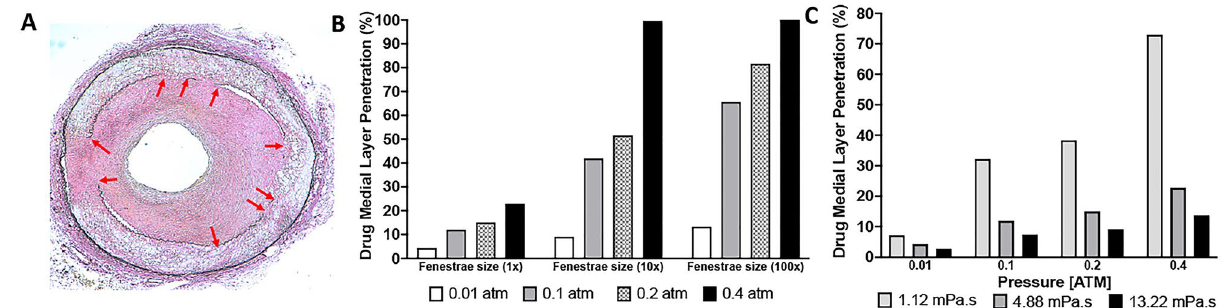
Figure 5. The impact of fenestrae size on liquid delivery. ( A ) Histological image of a disease artery showing disruption in the IEL (red arrows). ( B ) Mathematical results of varying fenestrae size at luminal pressures ranging from 0.01 atm to 0.4 atm. ( C ) Mathematical results of varying liquid viscosities at luminal pressures ranging from 0.01 atm to 0.4